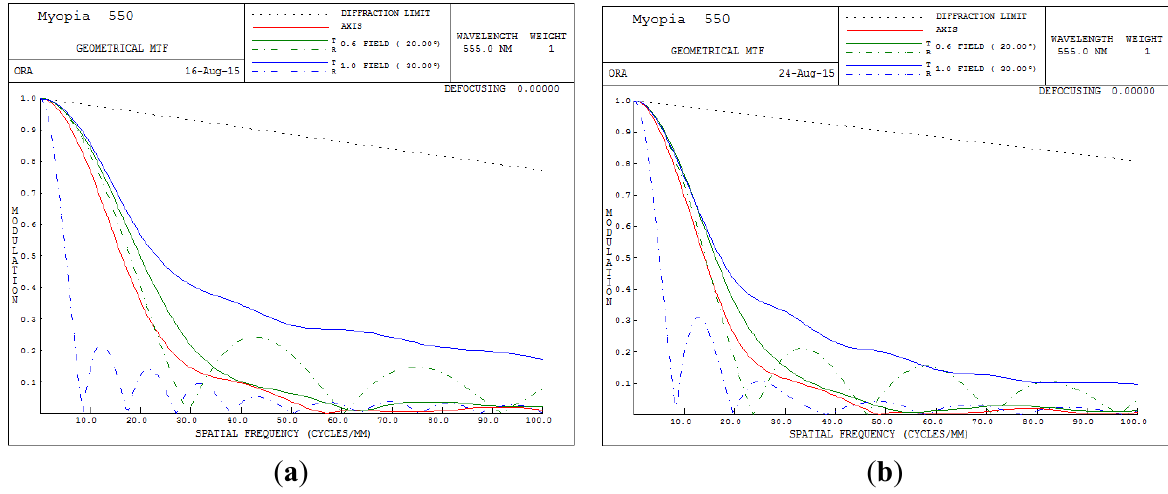
Figure 9. MTF plot after applying the built-in optimization method in CODE V. ( a ) 5 mm; ( b ) 6 mm.